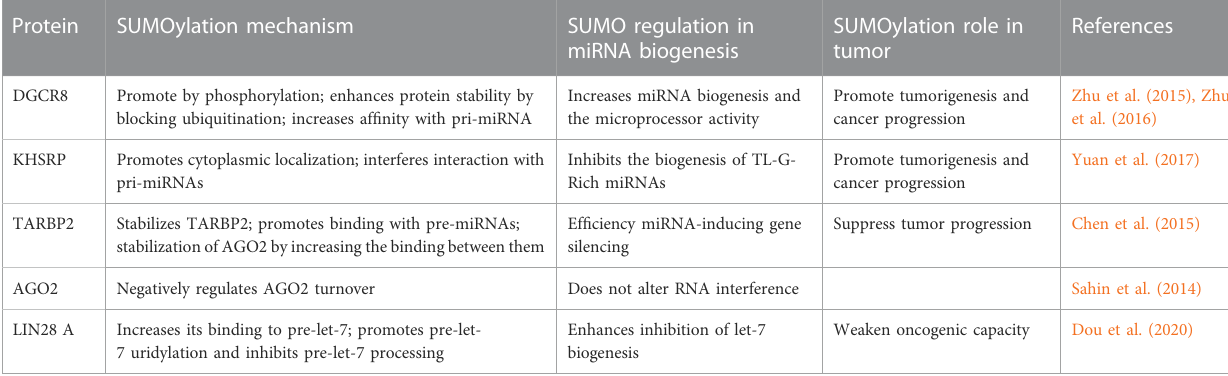
TABLE 3 SUMOylation affects miRNA biogenesis and functions in